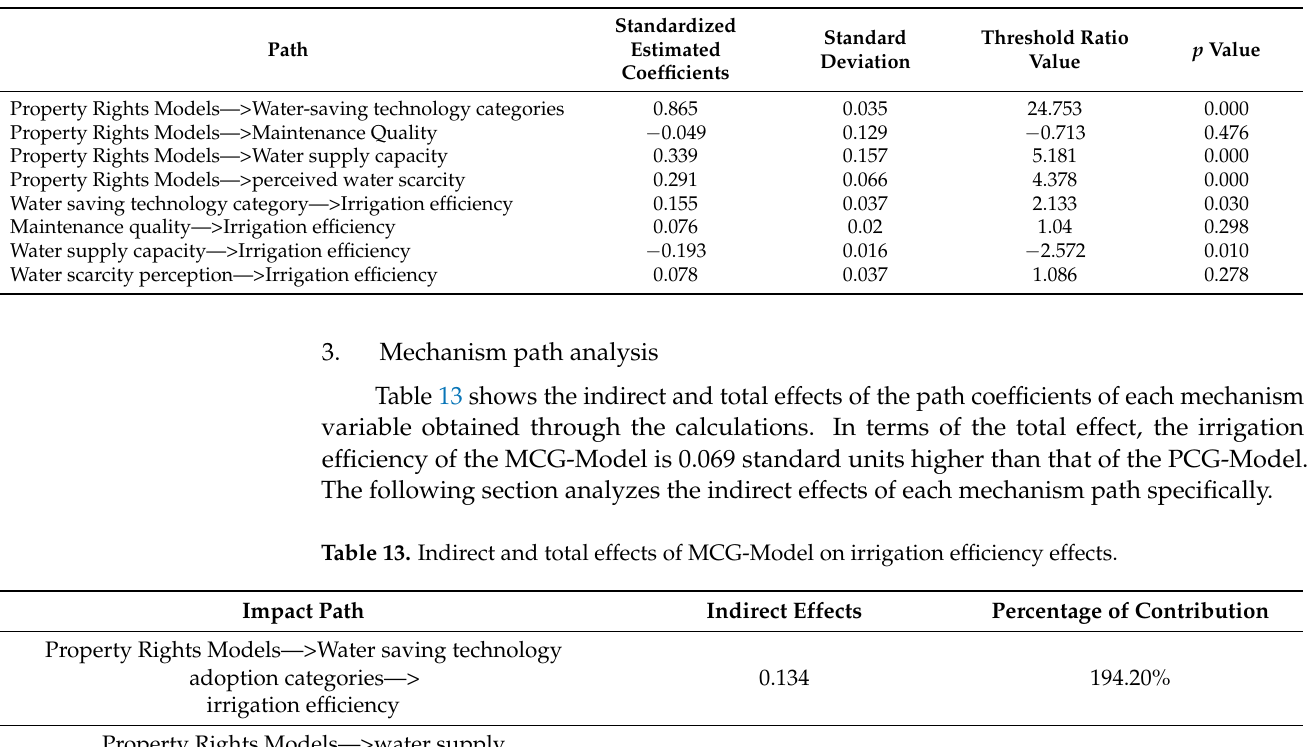
efficiency. ***, **represent significance at the 1%, and 5% statistical levels, respectively. efficiency. ***, ** represent significance at the 1%, and 5% statistical levels, respectively.